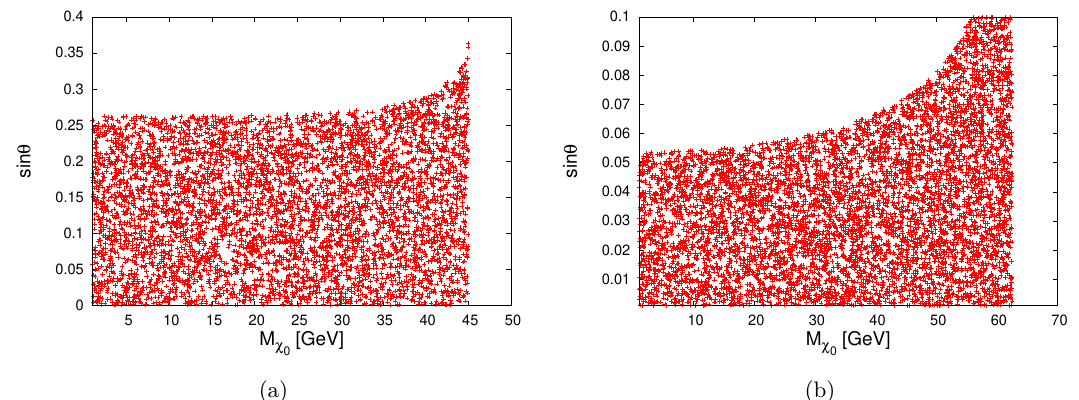
Figure 11 . (a) The allowed values of sin θ for different DM masses ( ≤ M Z / 2 ’ 45 GeV) from the invisible Z decay constraints and (b) from the invisible h ( ≤ M